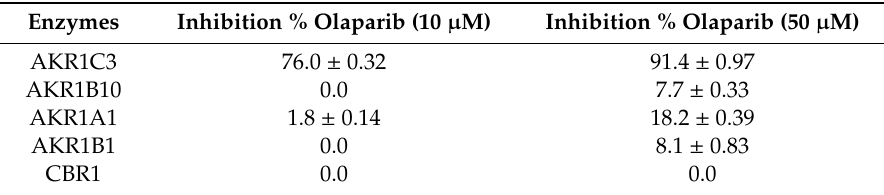
Table 1. Inhibitory effect of olaparib on anthracycline reductases.